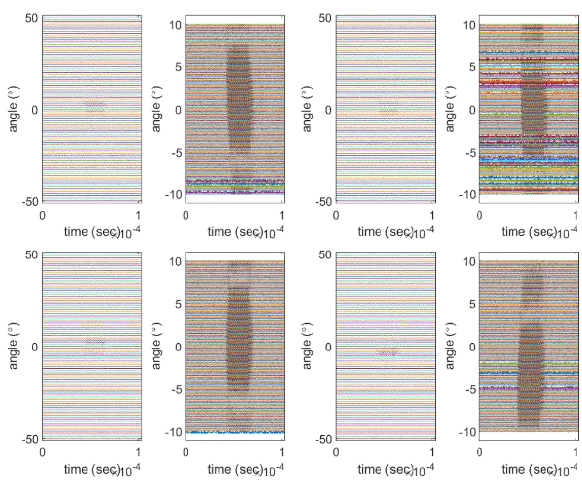
Figure 8. Example of raw data of the beam pattern of the sub-array: ( a ) ex 1; ( b ) zoomed ex 1; ( c ) ex 2; ( d ) zoomed ex 2; ( e ) ex 3; ( f ) zoomed ex 3; ( g ) ex 4; ( h ) zoomed ex 4.